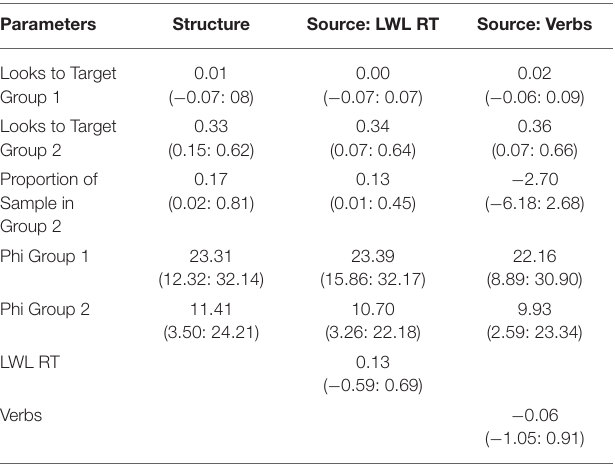
TABLE 3 | Parameter estimates for models of discrete individual differences.